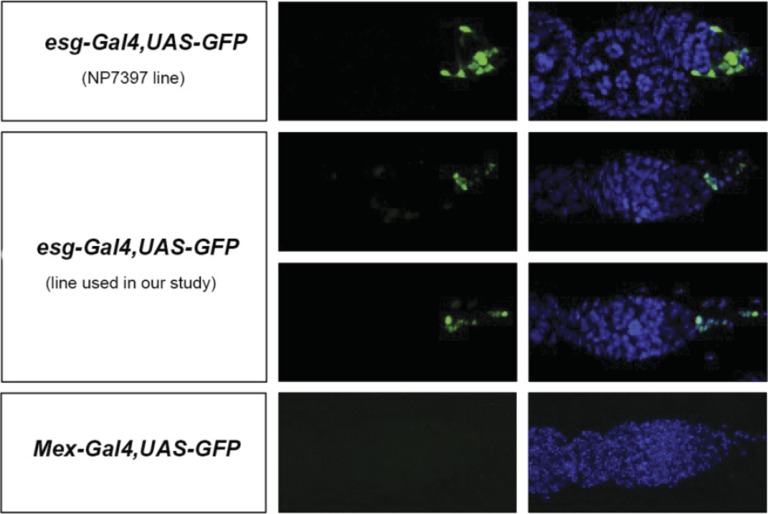
DOI:
http://dx.doi.org/10.7554/eLife.06930.014